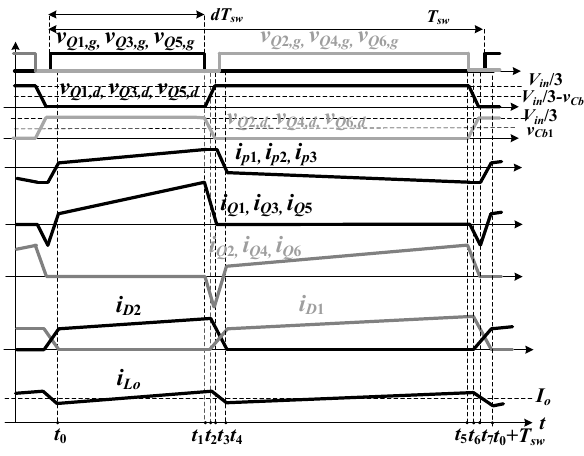
Figure 4. Main waveforms during one switching period.